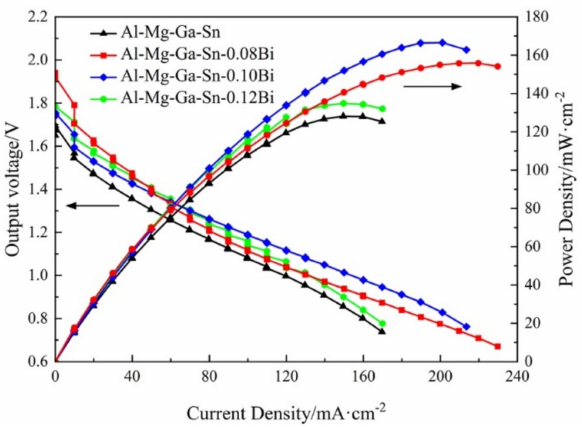
Figure 10. I-V discharge curves of Al-air batteries with different Al